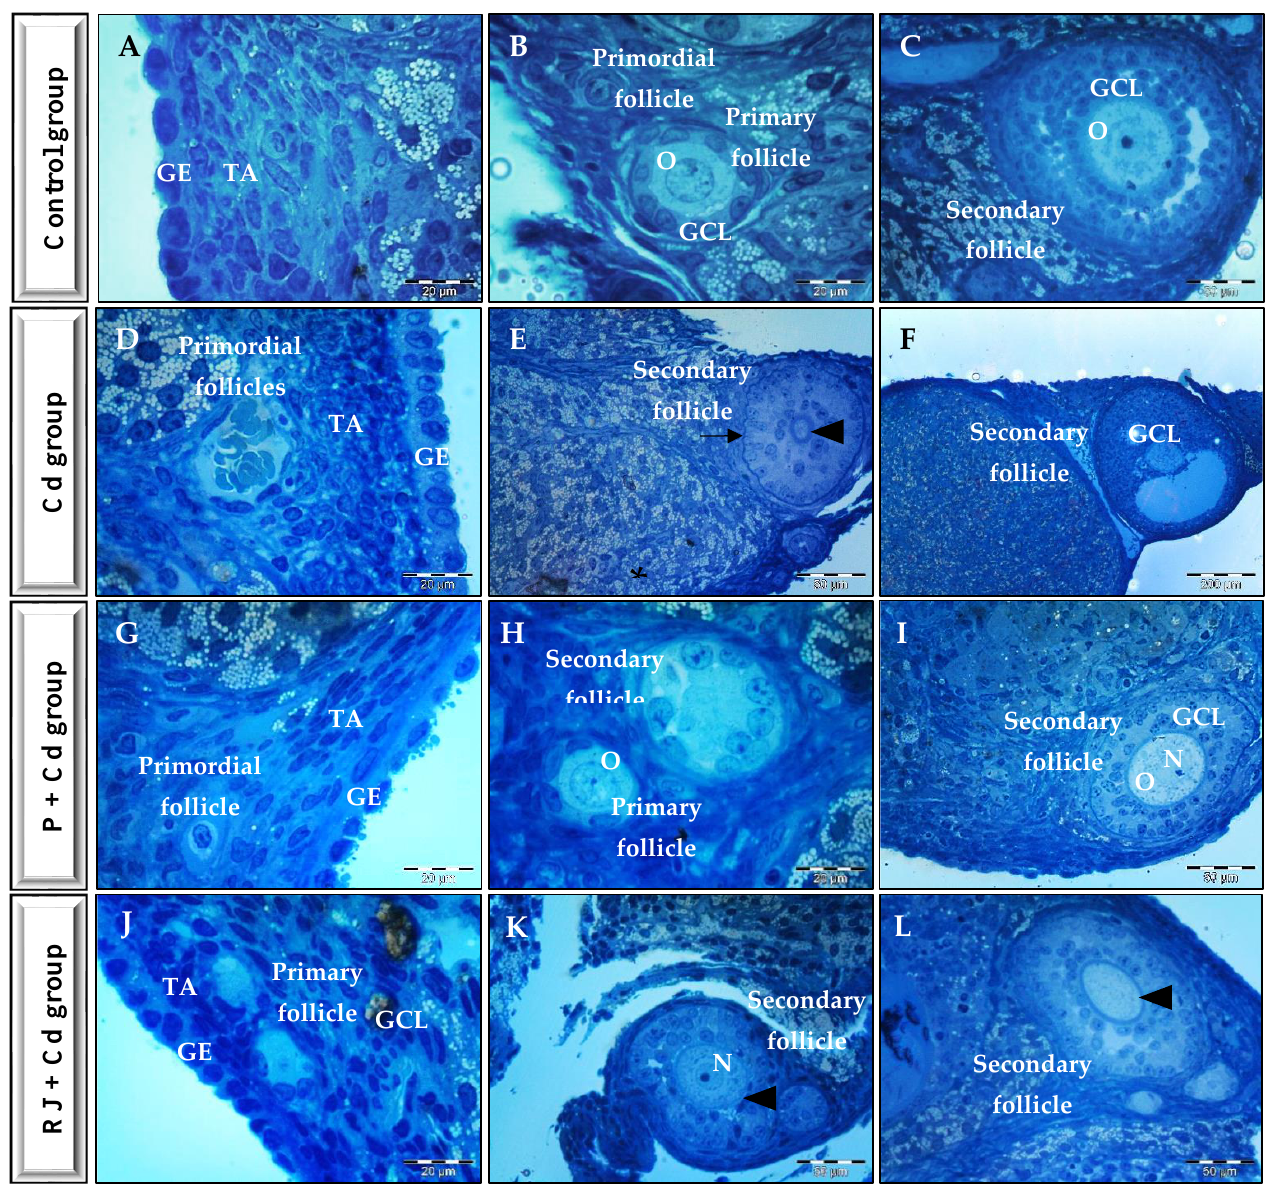
Figure 4. Photomicrographs of toluidine blue stained sections of ovaries from different experimental groups. Panels ( A – C ) show normal histoarchitecture of ovary; Panels ( D – F ) illustrate Cd-induced histopathology of the ovary with corrugated basement membrane (arrow), a relatively thick zona pellucida (arrowhead), fluid–filled space (asterix), and a degenerated granulosa cell layer at ( F ); Panels ( G – I ) show the architecture of ovary from animals pretreated with P for one week and then treated simultaneously with P and Cd; Panels ( J – L ) show the architecture of ovary from animals pretreated with RJ for one week and then treated simultaneously with RJ and Cd and restore normal zona pellucida appearance (arrowhead). GCL—granulosa cell layer, GE—germinal epithelium, N—nucleus, O—oocyte, TA—tunica